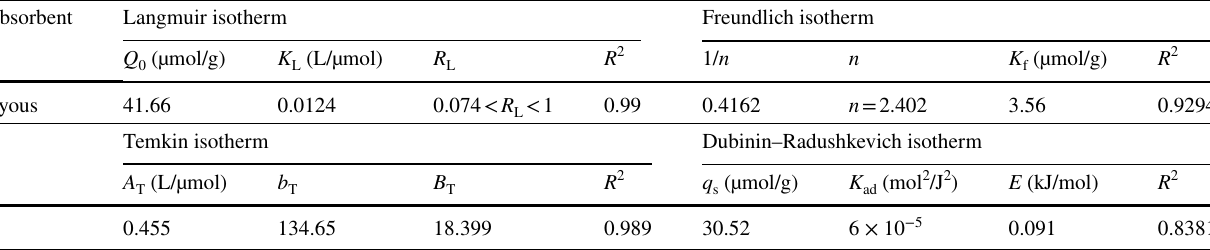
Table 3 Langmuir, Freundlich, Temkin and Dubinin–Radushkevich isotherm constants for the adsorption of paraquat onto Ayous sawdust